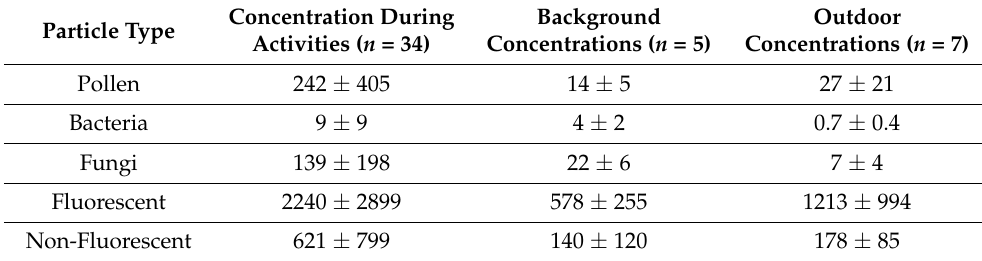
Table 1. Average concentrations (particles/liter) and standard deviations for particle types within all activities, in background and